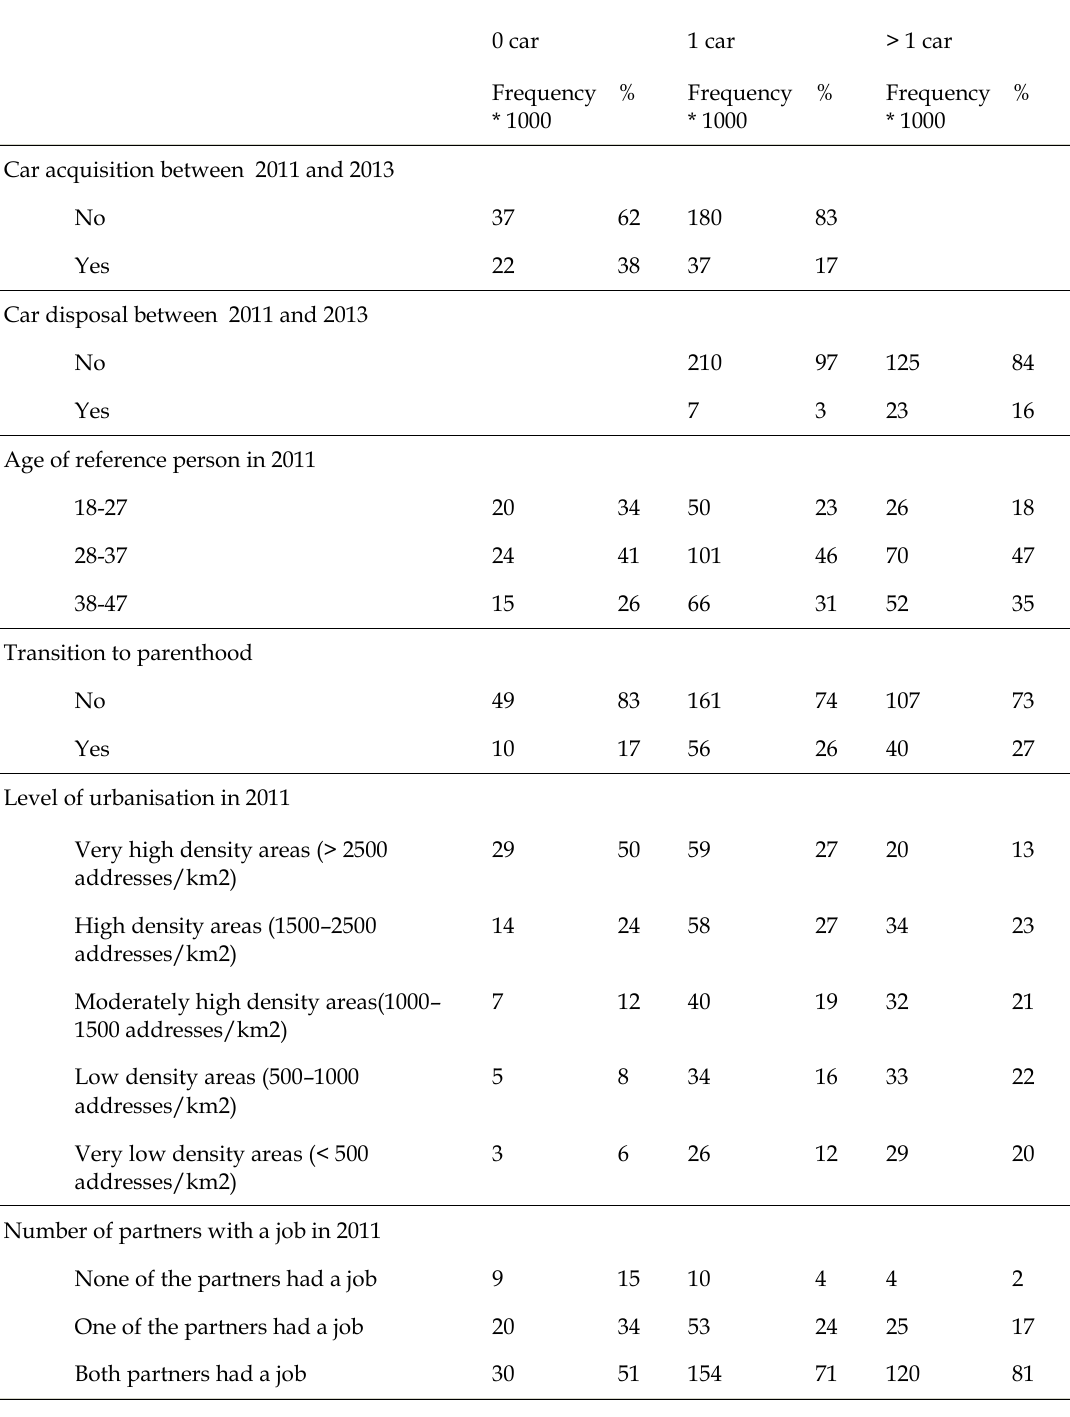
Table 1. Descriptive statistics of couples with no, one and more than one